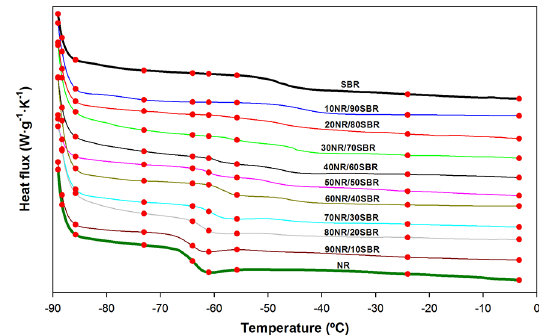
Figure 2. DSC curves expressing the heat flow against temperature (ºC) of the NR/SBR blends and 9 ( n = 11, n - 2 = 9) temperature points automatically selected by the SPA algorithm. The red dots indicate the selected temperatures.